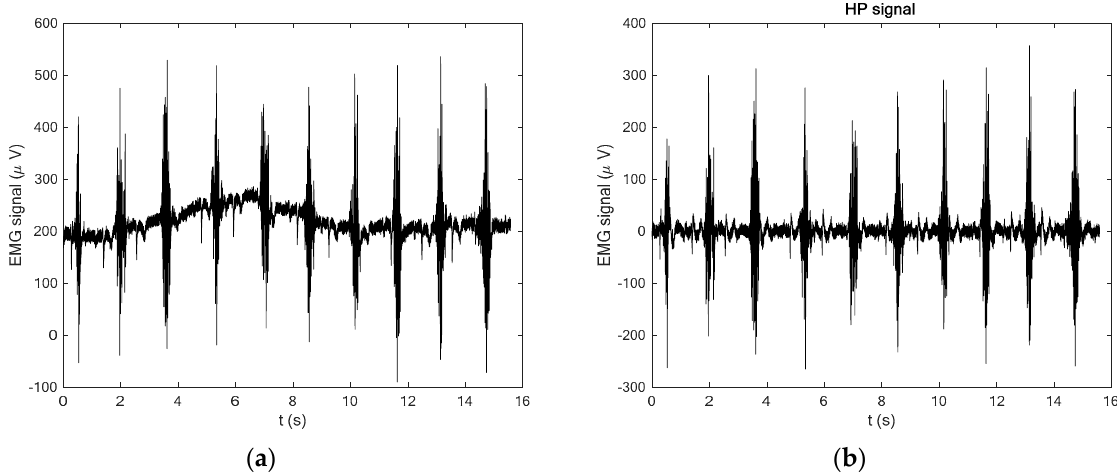
Figure 9. The example of the EMG signals measured on the right abdominal muscle, ( a ) raw signal, ( b ) after HP filtering using 3rd order Butterworth HP filter, f c = 2 Hz.